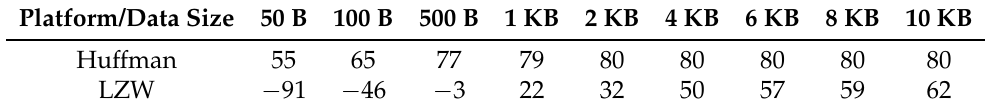
Table 5. Percentage of Space saving.